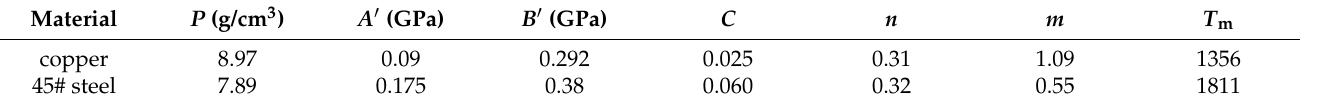
Table 1. Material model parameters.